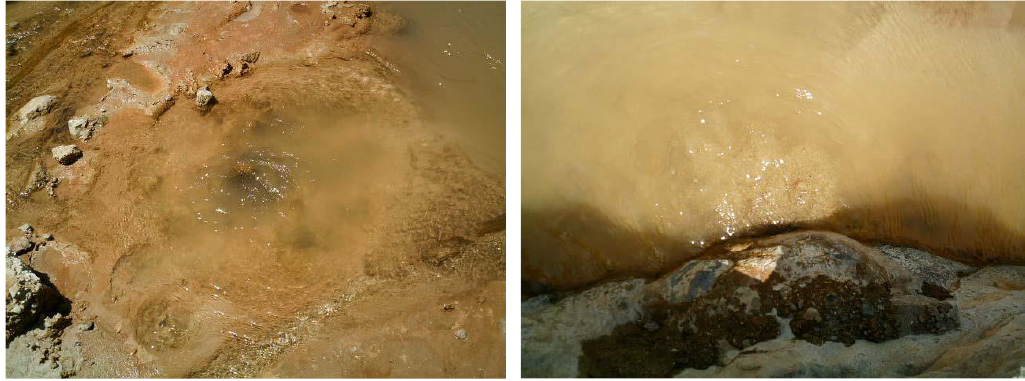
Figure 22. Sand downstream of the dam